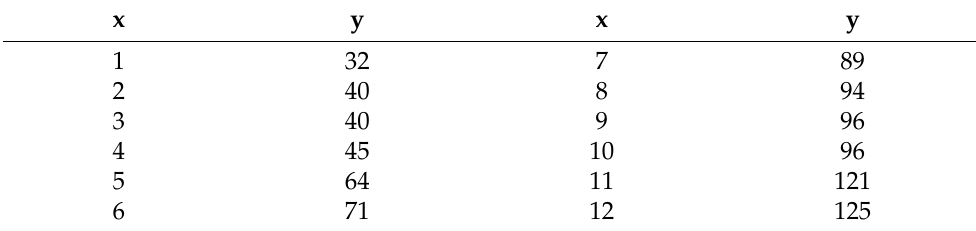
Table 1. Numerical data.